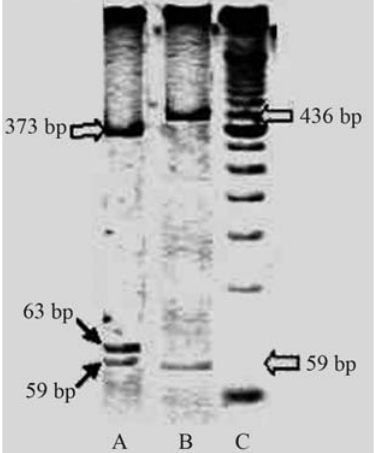
Figure 2 - Bovine and bubaline Hae III-RFLP of CSN2 exon VII visual- ized after electrophoresis on a 12% acrylamide gel: A, 373 bp, 59 bp and 63 bp fragments from cheese prepared with pure bovine milk; B, 436 bp and 59 bp fragments from cheese containing pure bubaline milk; C: 50 bp DNA Ladder.